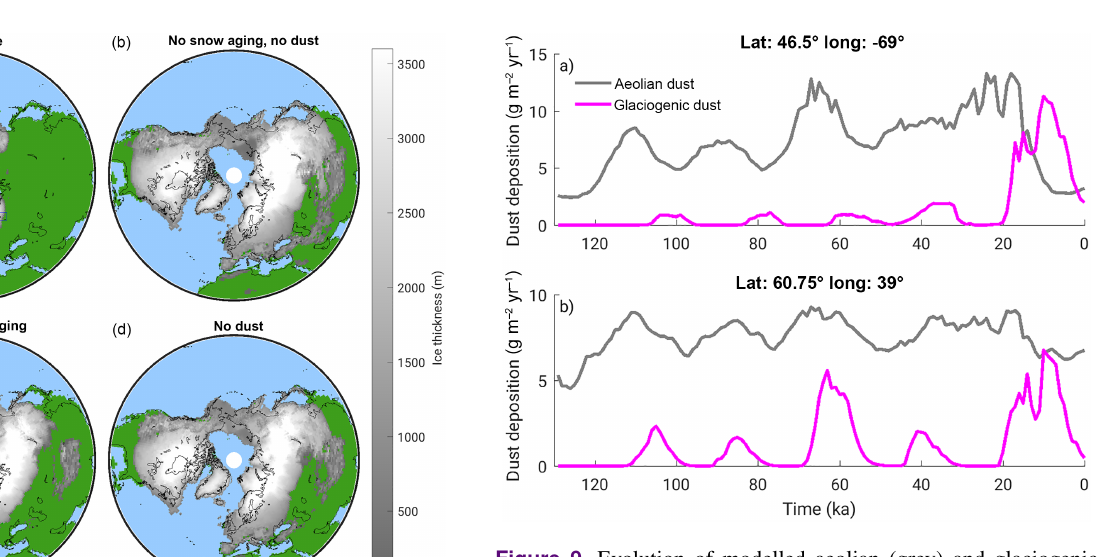
Figure 9. Evolution of modelled aeolian (grey) and glaciogenic (magenta) dust deposition at two locations at the southern margin of the LGM Laurentide (a) and Fennoscandian (b) ice sheets. The location of the two sites is indicated by the blue boxes in Fig.